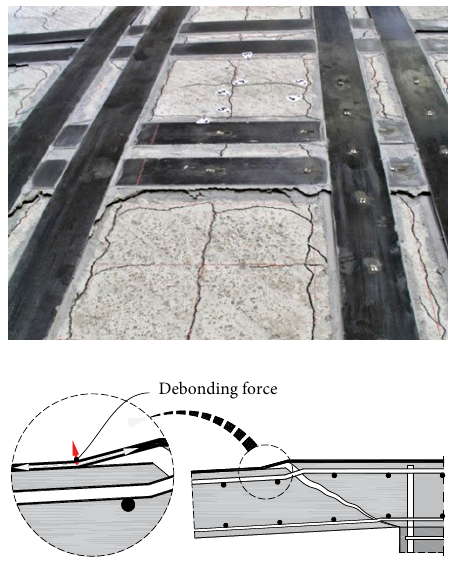
Figure 9. The failure mechanism on the edge of diagonal